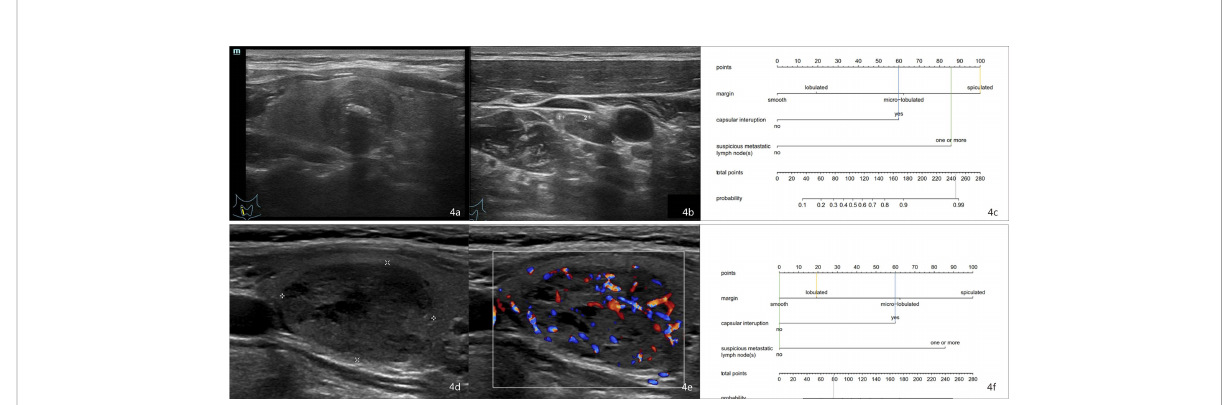
FIGURE 4 Examples of using the nomogram to predict the individual probability of CLNM by drawing straight lines across the diagram. First, draw lines straight upward to the point axis for each factor (margin status, orange line; capsular interruption, blue line; US-reported LN status, green line). Then, calculate total points for each of the predictors. Finally, draw a line (the gray line) straight down to the “ Total points ” scale to obtain the “ Risk ” of CLNM. (A) A 54-year-old man with MTC. (B) A small (size, 1.28 * 0.55 cm) lymph node was discovered, so the score was 85. The margin is spiculated, so the score was 100. The capsule is interrupted, so the score was 60. (C) The total point was 245 (100 + 60 + 85). The nomogram displayed that the chance of CLNM was more than 98%. Postoperative histology proved the positive CLNM. (D, E) A 60-year-old woman with MTC. The margin is lobulated, so the score was 20. The capsule is interrupted, so the score was 60. No suspicious lymph node was discovered, so the score was 0. The total point was 80 (20 + 60 + 0). (F) The probability of CLNM was approximately 30% by projecting a line straight down on the “ Total points ” scale. Postoperative pathology revealed that the patient has negative CLNM. CLNM, cervical lymph node metastasis; MTC, medullary thyroid